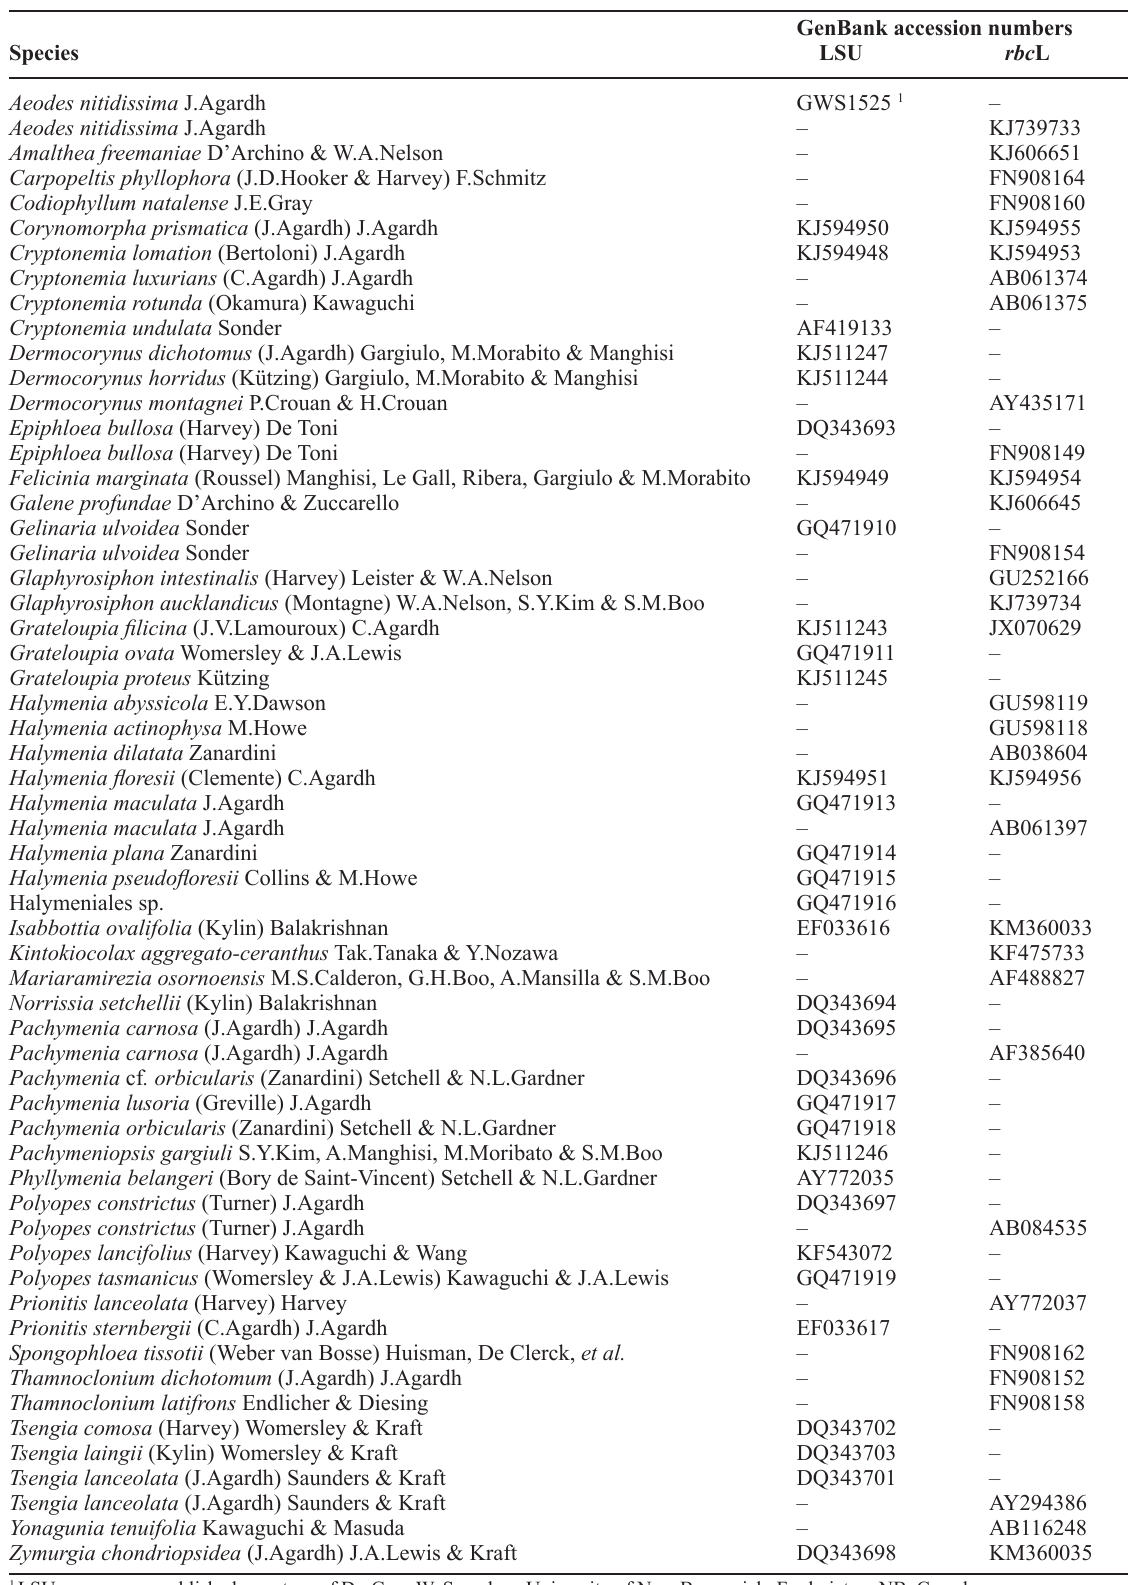
Table 3. List of sequences from GenBank used in phylogenetic